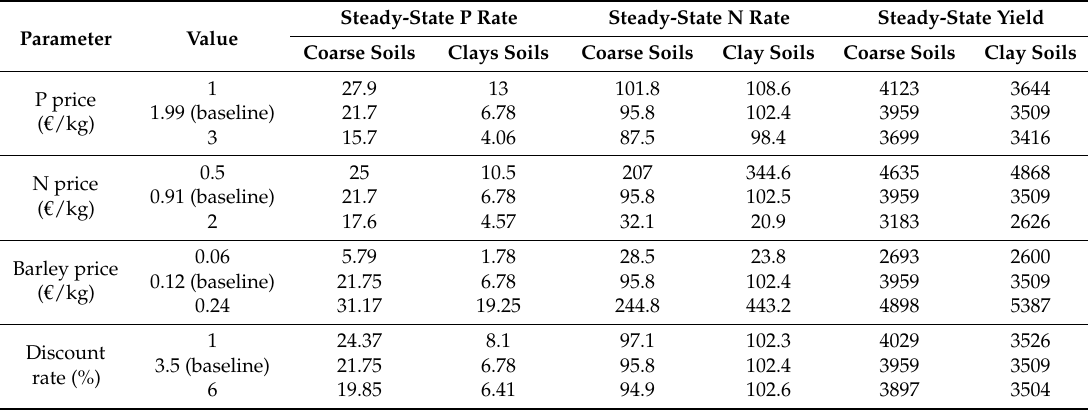
Table A2. The sensitivity of the steady-state N and P fertilizer rates and yields to the economic parameters of the